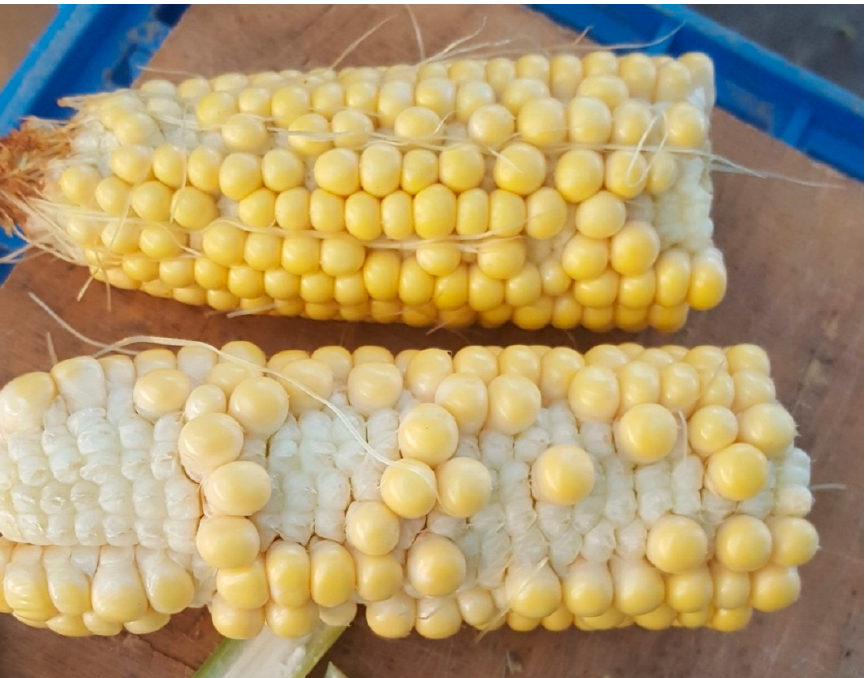
Figure 1. Reduced seed setting in summer maize (ZD958 sown in Hebei, China, in 2018) exposed to heat stress at the pollination stage. The temperature exceeded 35 °C at the time of pollen shed, affecting the pollen reception by initially emerged silks at the base of the ear as compared to the tip of the ear for late-emerging silks.